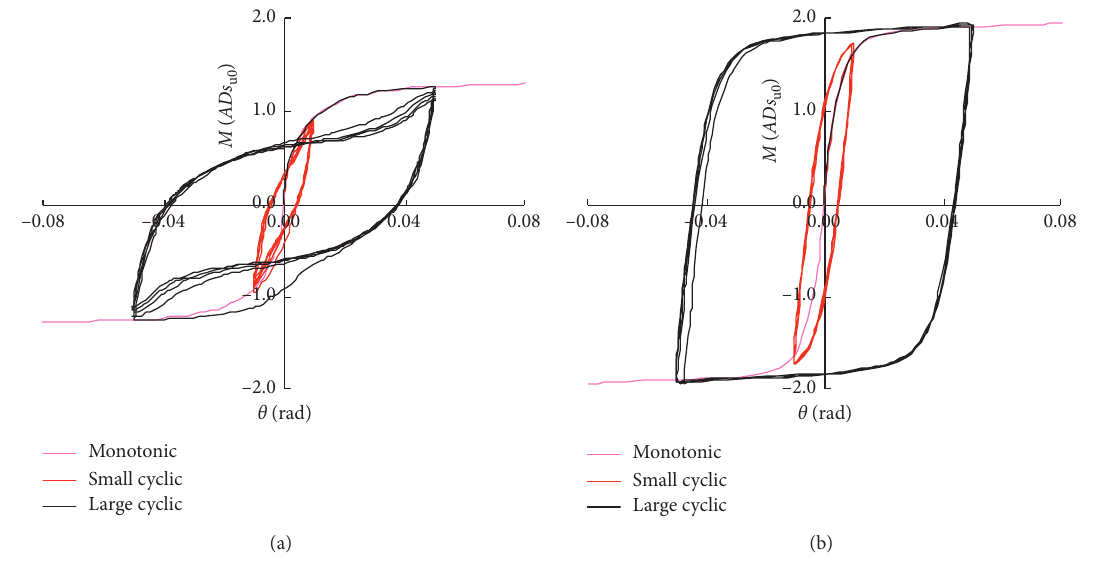
Figure 6: Relation of moment and rotation of bucket foundation of aspect ratio L / D � 0.6. (a) Imperfect interface. (b) Full bonding.